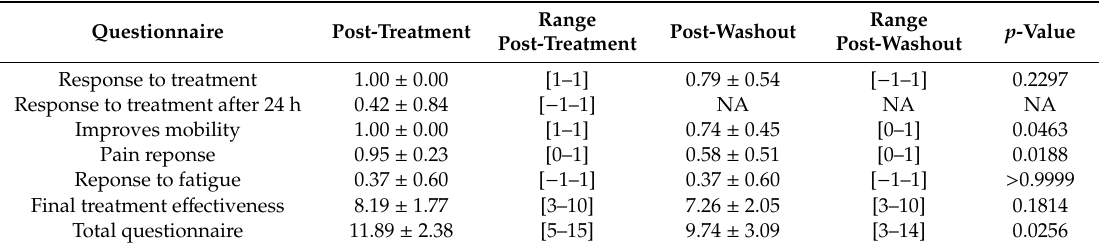
Table 6. FM only patient subgroup response to therapy, assessed by score-di ff erences in our CQ.